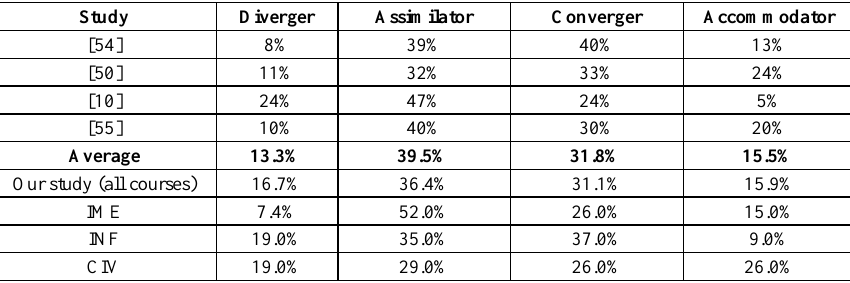
Table 8. Comparative results